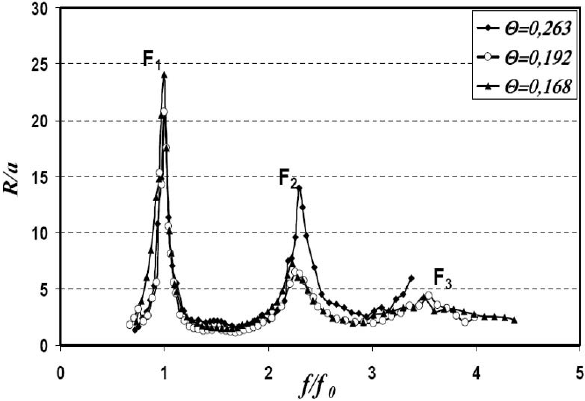
Fig. 4. Dependence of run-up amplification on normalized fre- quency for different bottom